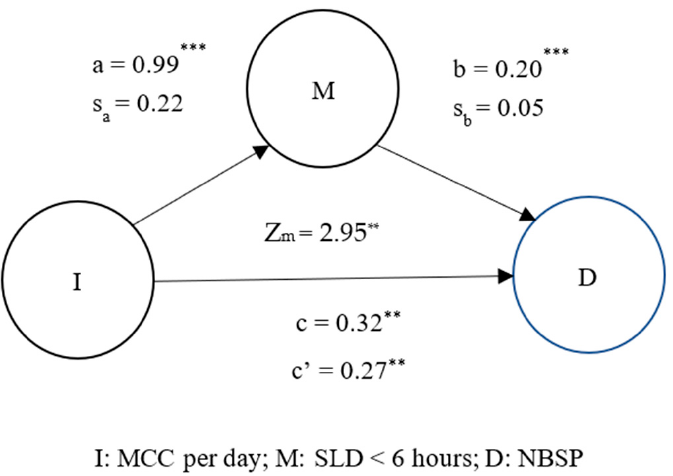
Figure 2. Mediation effect of SLD < 6 h on MCC per day and NBSP. ** p < 0.01; *** p < 0.0001; M, mediation factor; I, independent variable; D, dependent variable; c is the simple linear or logistic regression coefficient for the independent variable against dependent variable in the absence of mediation factor; c’ is the binary linear or logistic regression coefficient for the independent variable against dependent variable in the presence of mediation factor; a is the simple linear or logistic regression coefficient for the independent variable against the mediation factor; b is the regression coefficient for the mediation factor against the dependent variable in the binary linear or logistic regression model; s a and s b represent the standard deviations of a and b .